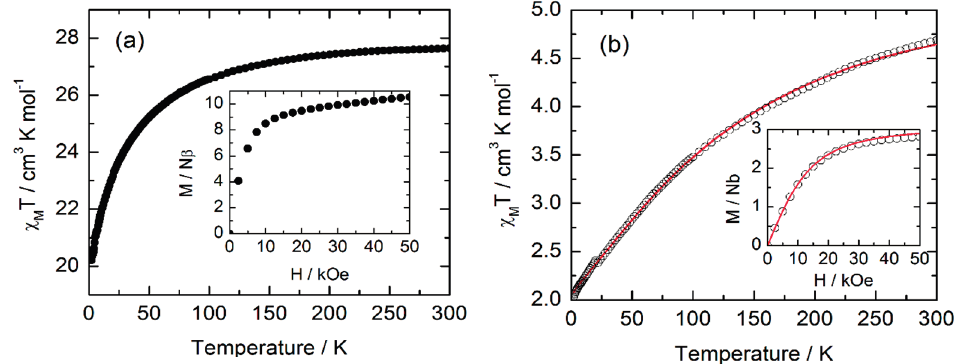
Figure 7. ( a ) Temperature dependence of χ M T for 1 . Inset: field variation of the magnetization measured at 2 K; ( b ) Temperature dependence of χ M T for 2 . Inset: field variation of the magnetization measured at 2 K. The red line corresponds to the best-fitted curve (see text). χ M , molar magnetic susceptibility; T , temperature in